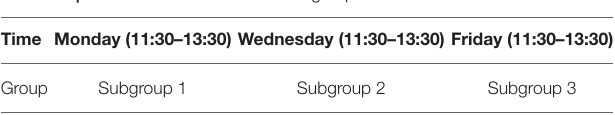
TABLE 1 | Time of interventions for each